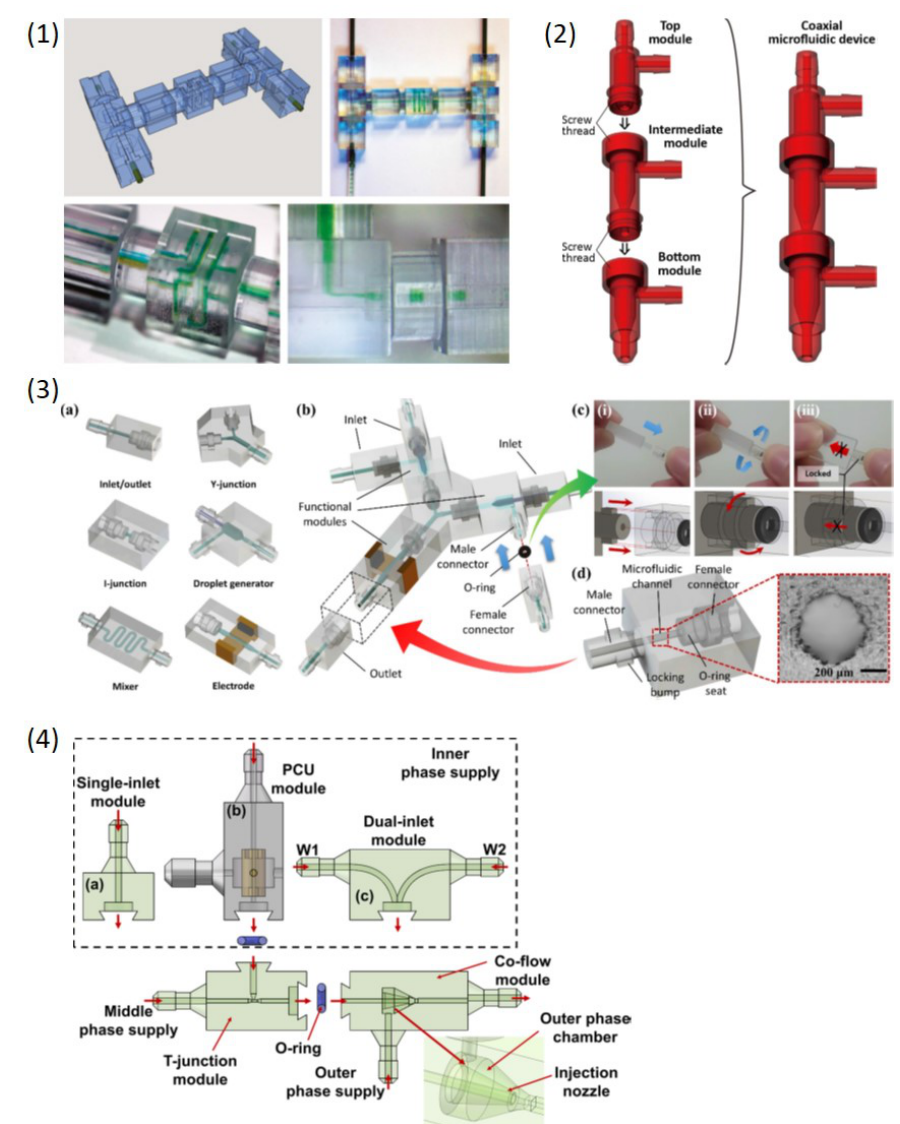
Figure 8. Modular droplet microfluidic devices. ( 1 ) 3D-printed modules were assembled to form a T-junction and a 3D helical mixer. Each module was connected with a male-male connector aligned with female-type ports. ( 2 ) Different 3D-printed modules were assembled to produce single and double emulsions. A notch structure with an O-ring connected each module. ( 3 ) Assembled 3D-printed modules to produce multiple emulsions with screw-thread as connection. ( 4 ) Various functional 3D-printed modules can be assembled to achieve different functions including droplet generation and manipulation. Male-female connectors with locking bump and O-rings connected each module. Reproduce of